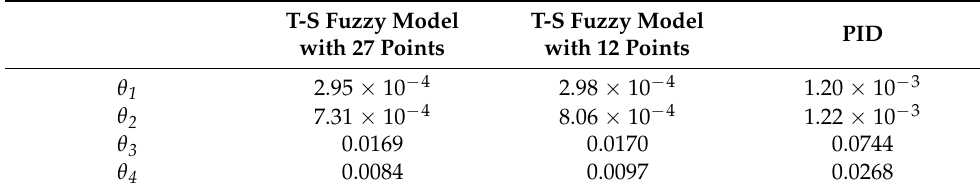
Figure 6. Simulation results of the fuzzy optimal controllers for the flexible robot. Table 4. MSEs of command tracking with the designed